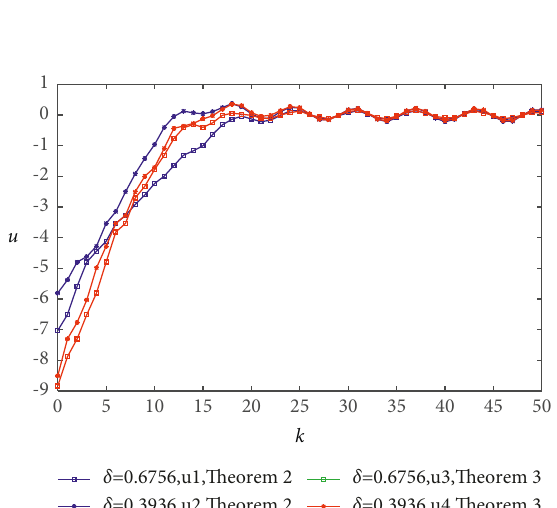
Figure 9: c ( k ) trajectory.